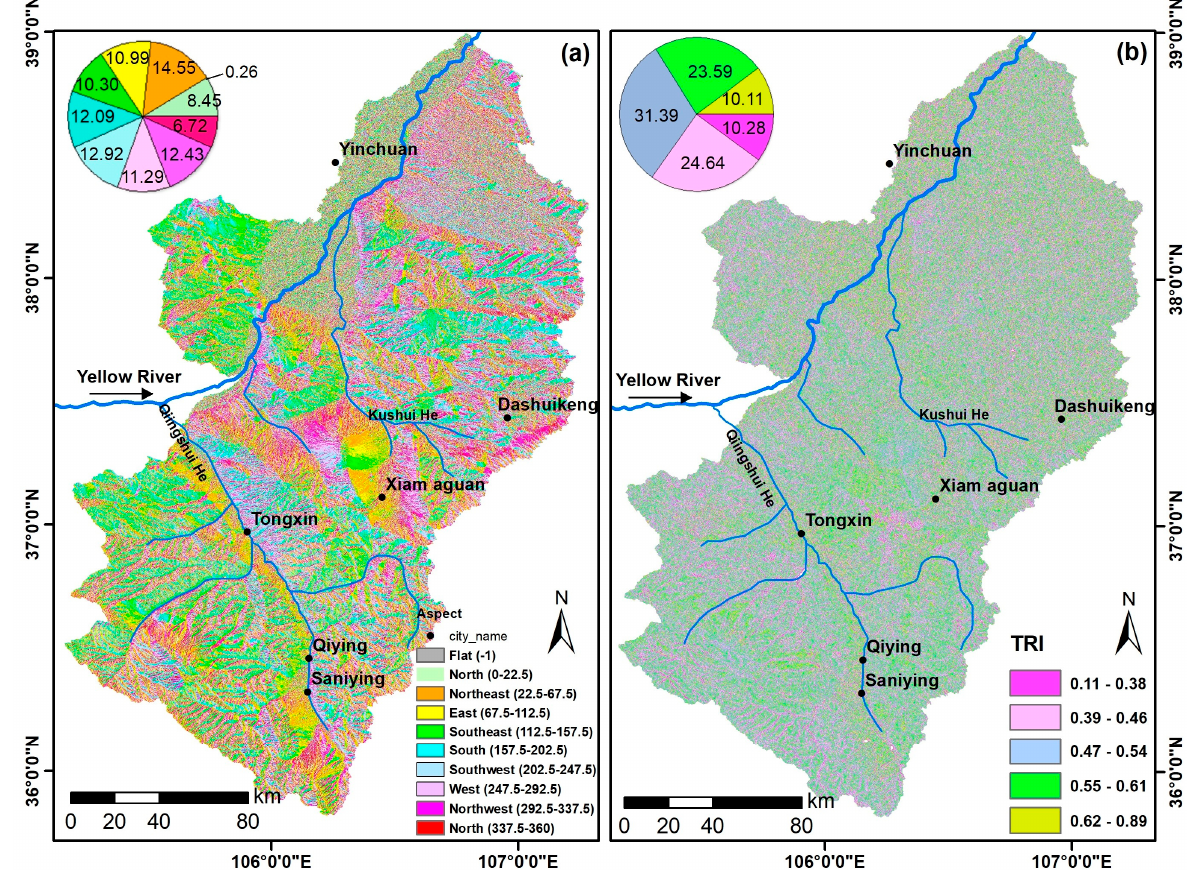
Figure 4. ( a ) Aspect map of the study area; ( b ) Terrain roughness index of the present study.